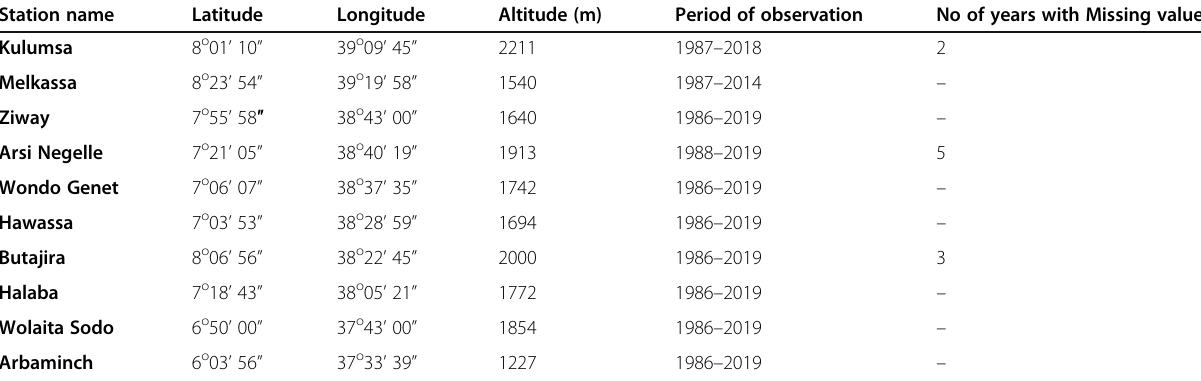
Table 1 Lists of Meteorological stations used in the